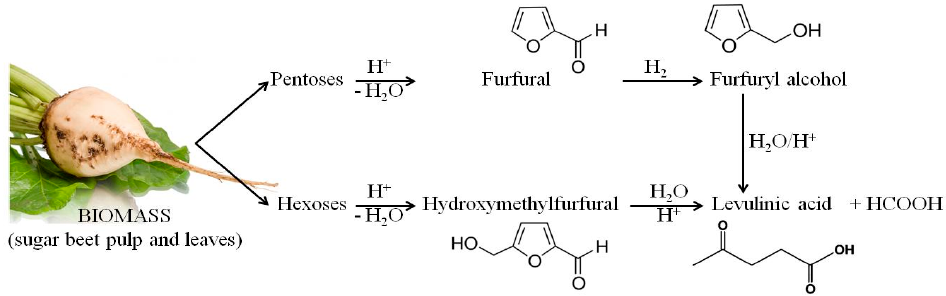
Figure 6. Products of acid hydrolysis of waste biomass from the sugar industry.